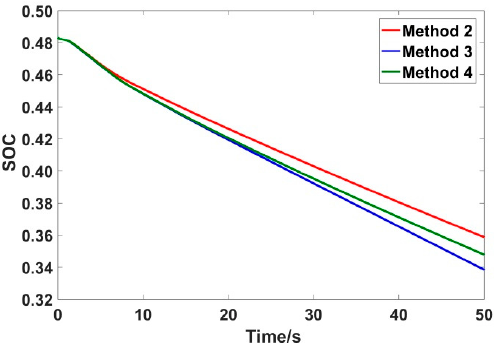
Figure 7. SOC (state of charge) curves of the energy storage system.